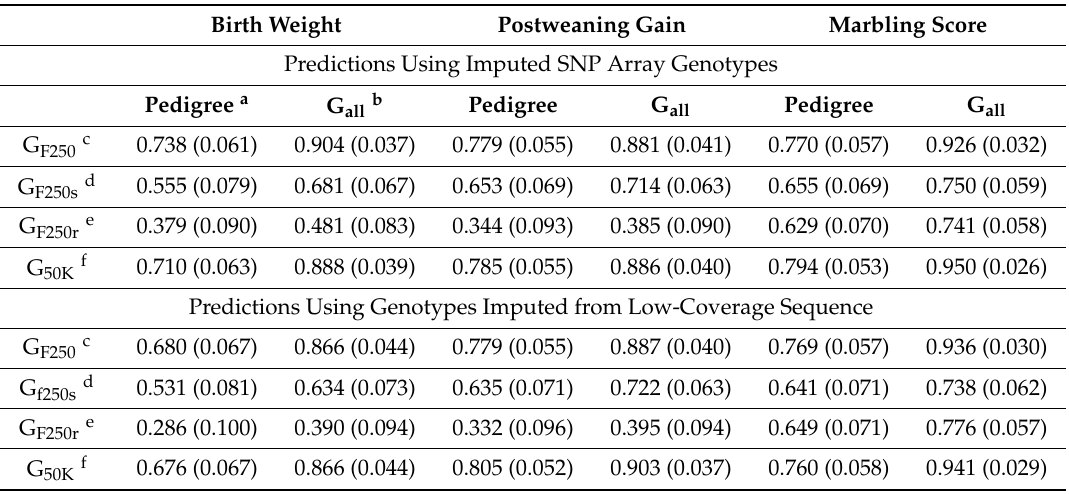
(cid:80) Table 5. Correlations (SE) between molecular breeding values ( (marker e ff ect estimates × genotypes)) and predicted breeding values. Birth Weight Postweaning Gain Marbling Score Predictions Using Imputed SNP Array Genotypes Pedigree a G all b Pedigree G all Pedigree G all G F250 c